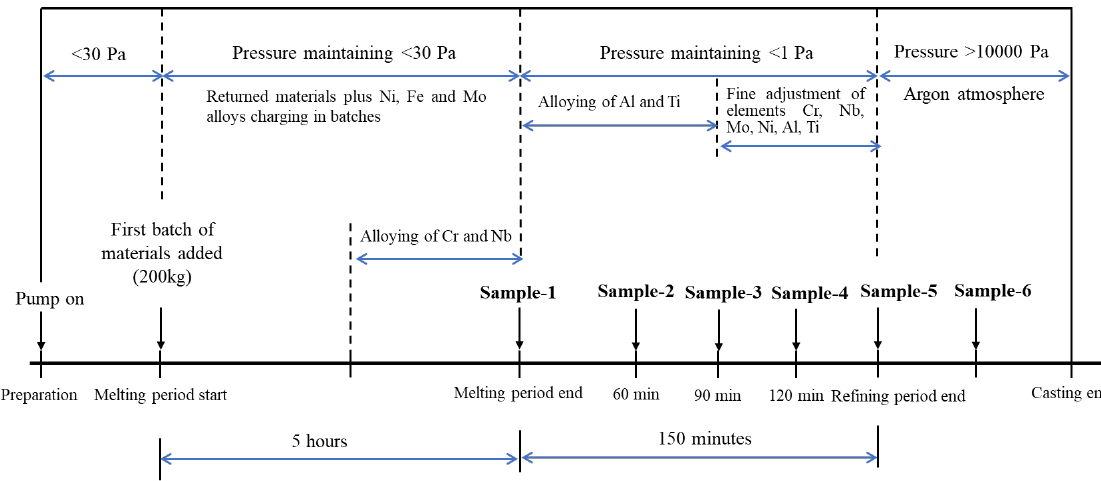
Figure 2. Detailed operations during the process of VIM.